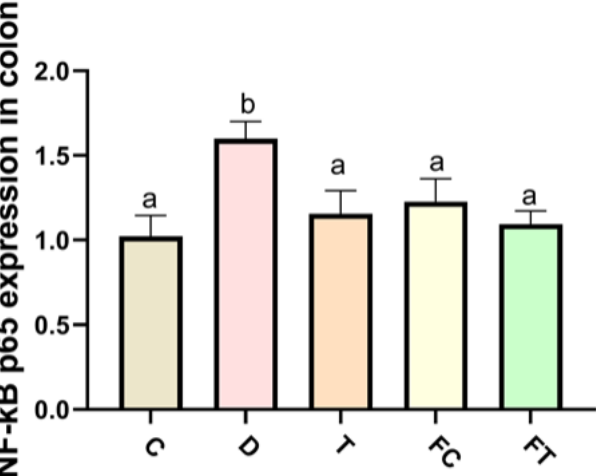
Figure 5. Taxifolin and FMT reduced the expression of inflammatory factors by the NF- κ B signal path in colon tissue in DSS treated mice. The expression level of the NF- κ B signal path gene NF- κ B P65 in each group were detected. Data are mean ± SEM ( n = 7). The letters ab are significant markers, and any difference with one of the same marker letters is not significant, and any difference with different marker letters is significant.